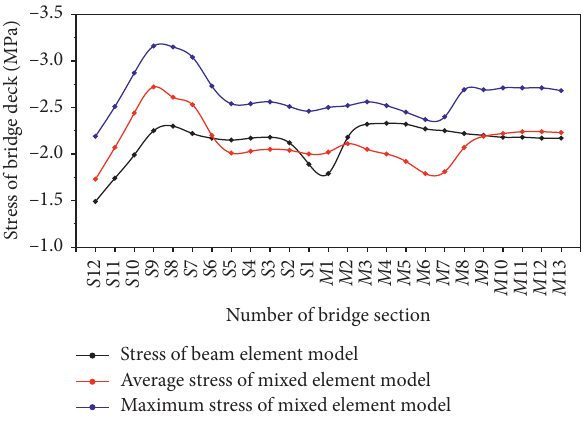
Figure 16: The stress distribution of the upper edge of the cross section of the bridge deck.